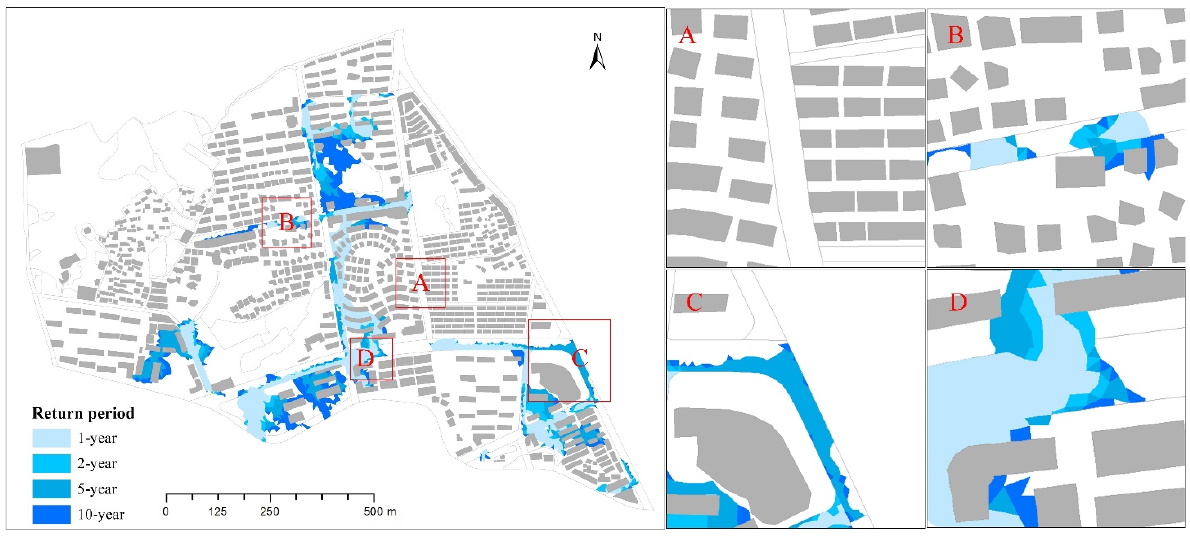
Figure 10. Inundation of the study area during different return periods ( t = 120 min and r = 0.4): ( A ) XJSR, ( B ) NLS, ( C ) AFR, ( D ) WSS.